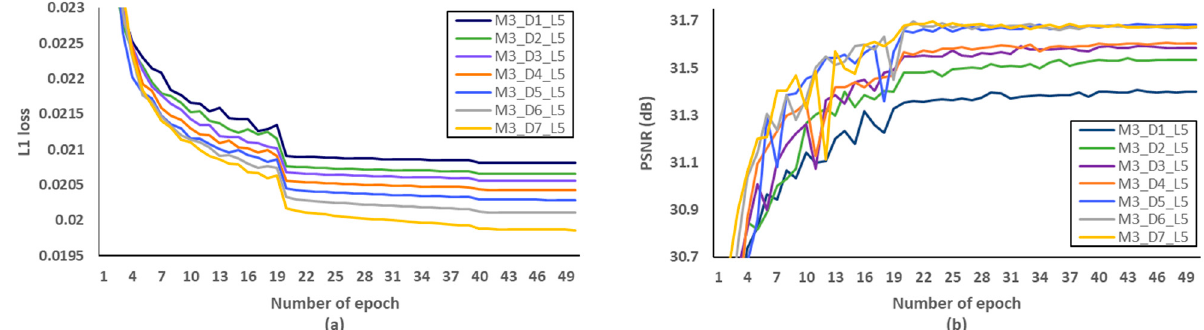
Figure 11. Verification of the number of dense block (D) per a MCDB in terms of SR performance. ( a ) L1 loss per epoch. ( b ) PSNR per epoch.